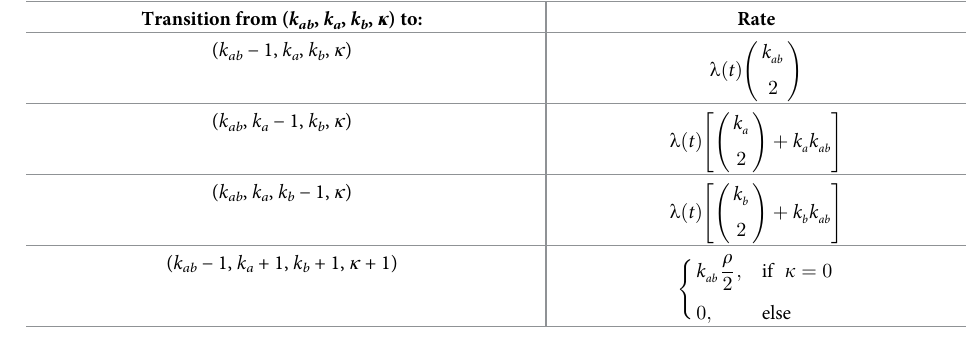
Table 1. The table shows the possible transitions out of a given state ( k first row gives the rate for coalescence between two lineages that are ancestral to both loci. The second row gives rate for two types of events, coalescences between two lineages ancestral to only locus a , and coalescences of a lineage ances- tral only to a with a lineage ancestral to both. The third row reflects similar events for locus b. The last row gives the rate of recombination events. Note that these rates are defined to permit a maximum of 1 ancestral recombination event occurring between locus a and b . Transition from ( k ab , k a , k b , κ ) to: Rate ( k 1, k , k , κ ) ab − a b ( k ab , k a − 1, k b , κ ) ( k ab , k a , k b − 1, κ ) ( k ab − 1, k a + 1, k b + 1, κ + 1) ( k